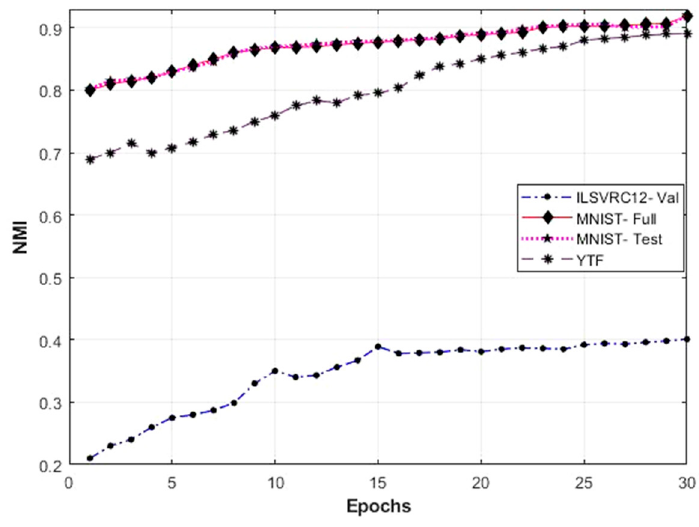
Figure 6. Comparison of NMI performances of the proposed method versus the number of training epochs for three datasets (ILSVRC12-Val, MNIST, and YTF).